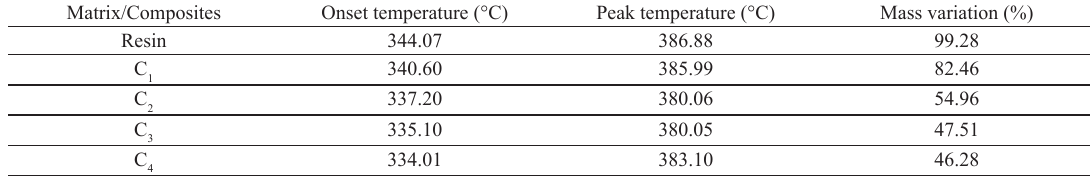
Table 8. Tonset, Tpeak and mass loss values for the composites and the polyester resin. Matrix/Composites